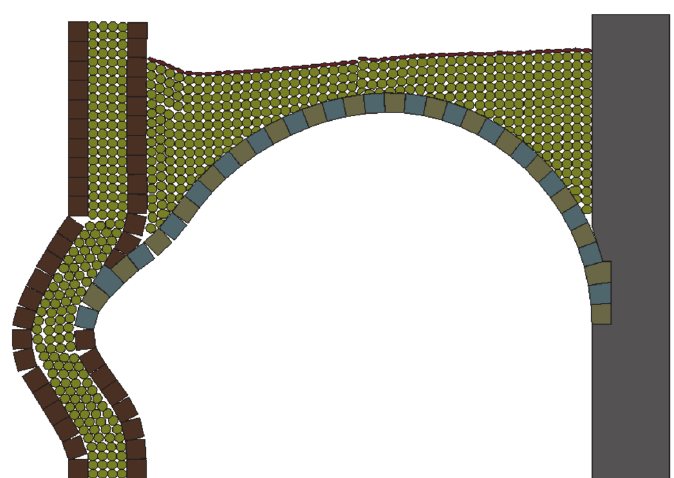
Figure 6: Deformed configuration after 0.9 sec for scenario S2 (L=7.1m).